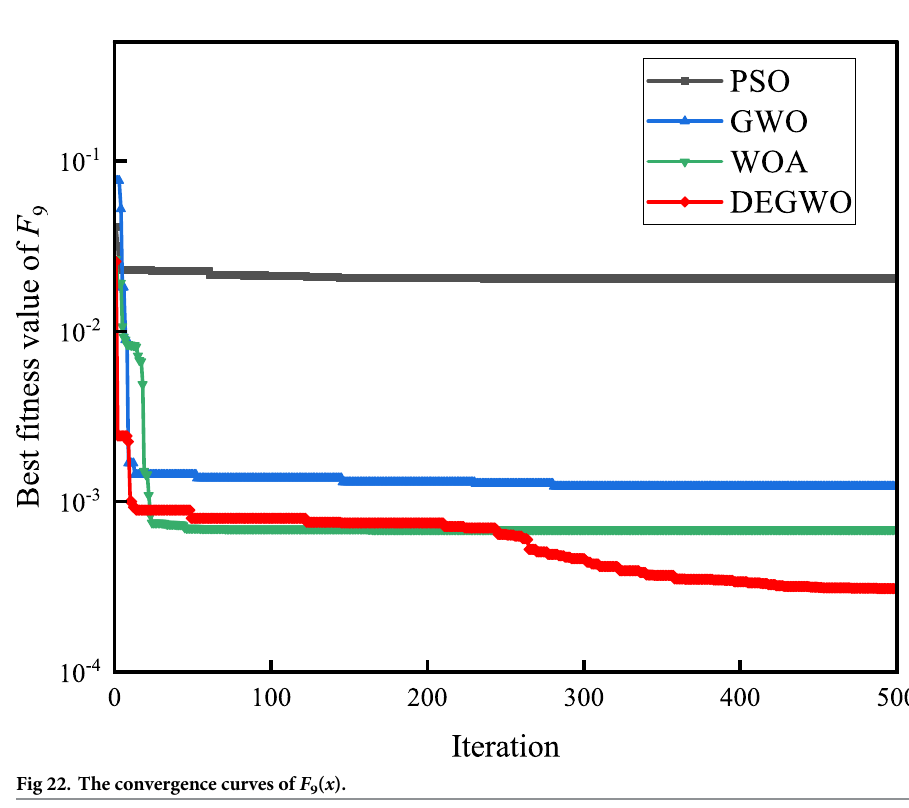
Fig 22. The convergence curves of F 9 ( x ).